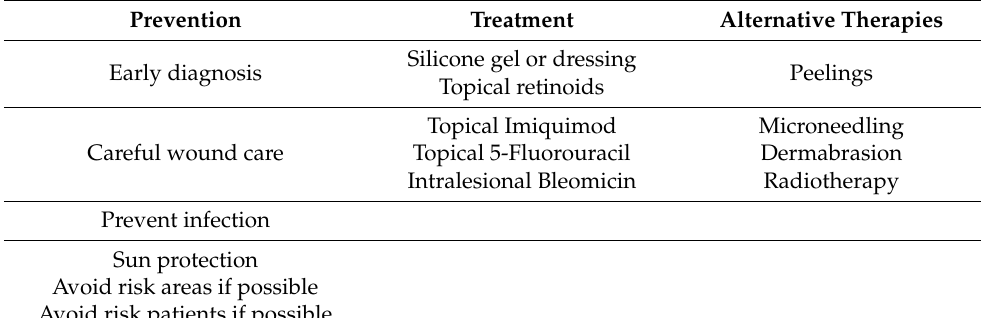
Table 3. Prevention and treatment of scarring, keloids, and hypertrophic scars (HS).